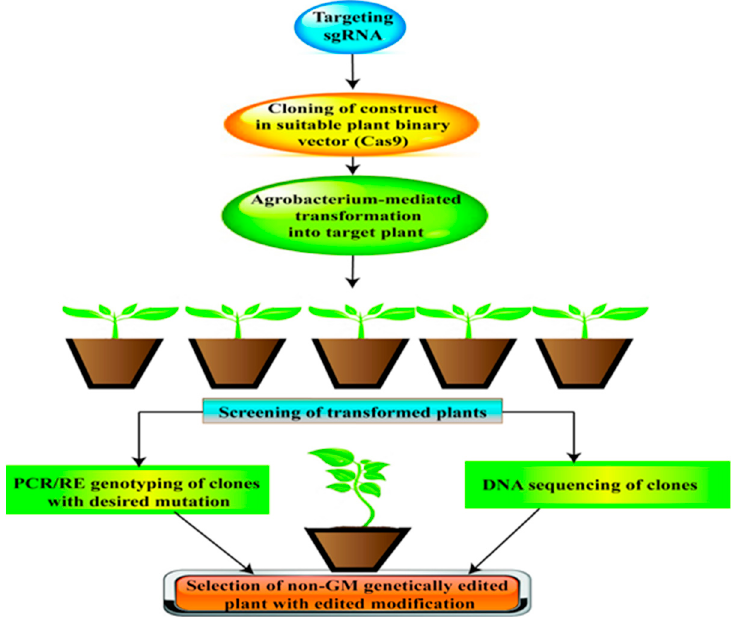
Figure 4. Schematic representation of an approach of genome editing (GE) with Cas9 / sgRNA. First, the target gene is selected; sgRNAs are designed and synthesized using online tools. Generally, cloning of target sgRNA with Cas9 (or with its variant) is performed using a plant binary vector for Agrobacterium -mediated transformation into target plant species. Transformed plants are then selected for the presence of Cas9 and sgRNA, followed by PCR / RE genotyping. Finally, DNA sequencing is used for selecting the plants with the desired editing / mutation.